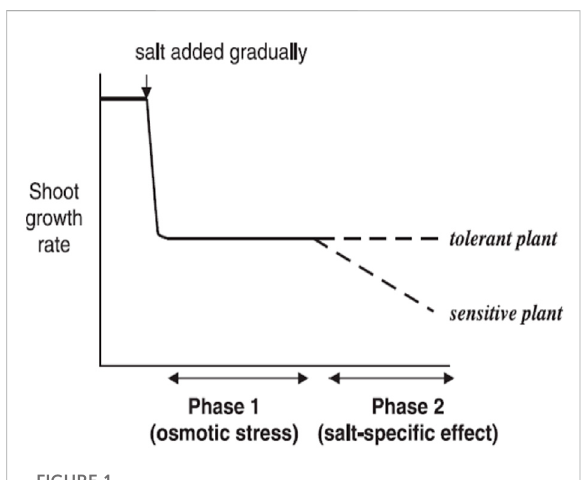
FIGURE 1 Salinityinducesatwo-phasegrowthperformanceindifferent salt-sensitive plants (Munns,